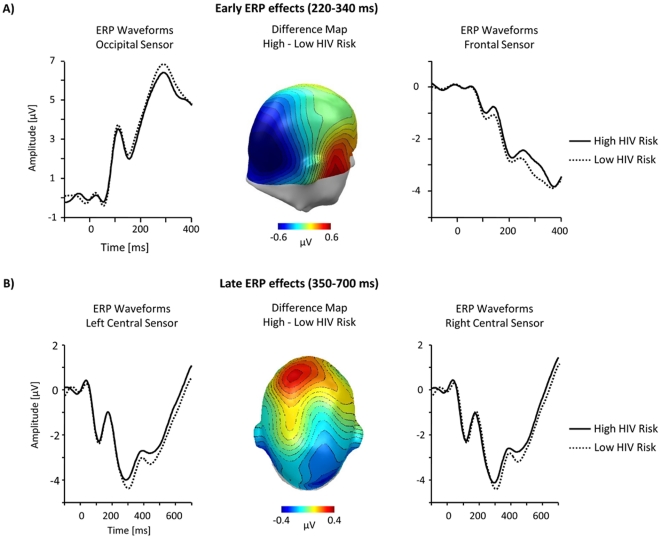
Relationship between HIV Risk ratings and ERPs.(A) Representative ERP-waveforms for high and low risk stimuli over occipital (left panel) and frontal (right panel) sensor sites. The scalp potential map shows the topography of the difference between the high and low risk stimuli averaged across the time window from 220–340 ms (middle panel). (B) Representative left and right centro-frontal sensor sites illustrate the late ERP effect. The difference scalp map (high - low risk) shows the topography of the risk modulation in the LPP time window (350–700 ms).